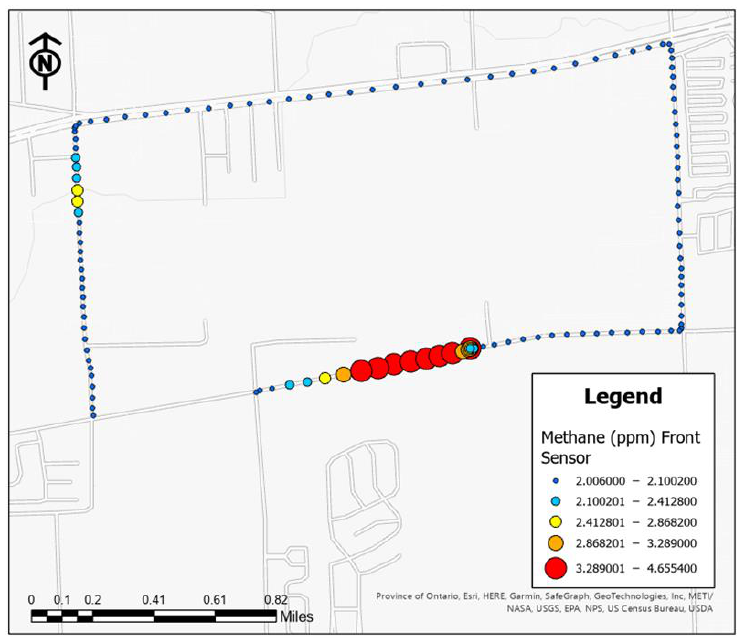
Figure 13. CH 4 concentrations (ppm) measured by MPAL on 28 September 2021, 9:01 a.m. to 9:22 a.m. The wind measured by the MPAL during the period of interest was close to calm (~1 m/s), and so the MPAL could not be relied on to provide a stable wind direction. The nearest airport reported anemometer-level winds of 10 mph (=4.47 m/s) from the direction of north northeast (NNE).